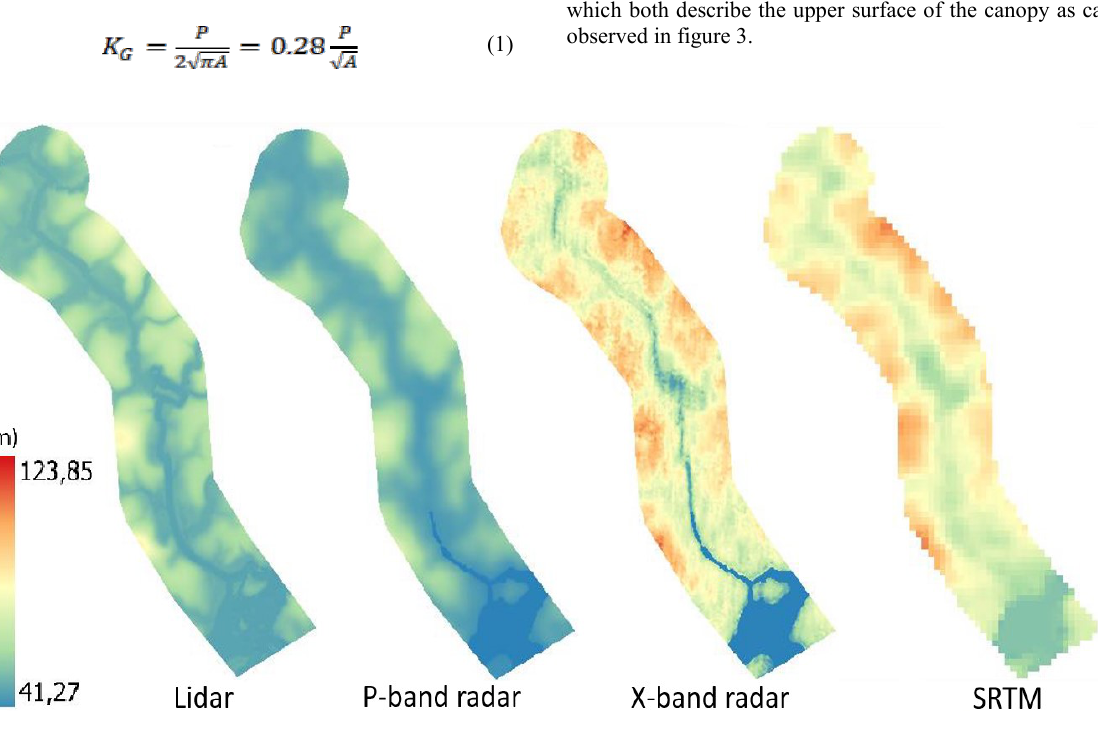
Figure 3. Comparison of the P-band radar DTM with the reference lidar DTM and other DEMs in color hypsometry